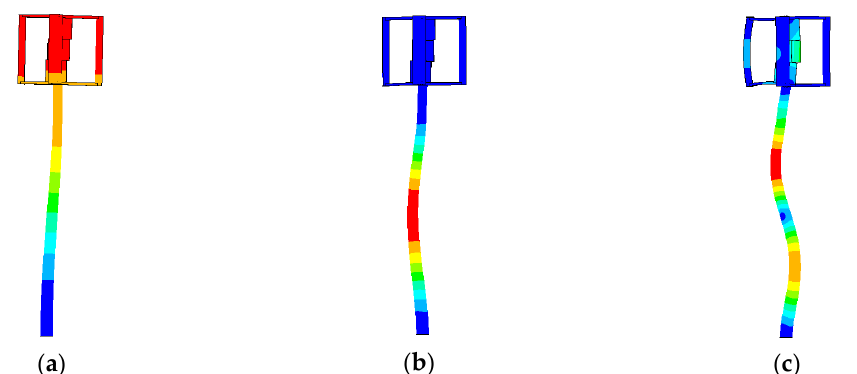
Figure 15. First three mode shapes of the H ‐ type VAWT from its SEM that correspond to its X ‐ Y planar motion: ( a ) the first mode shape with the natural frequency 1.92 Hz; ( b ) the second mode shape with the natural frequency 50.2 Hz; and ( c ) the third mode shape with the natural frequency 154.1 Hz.